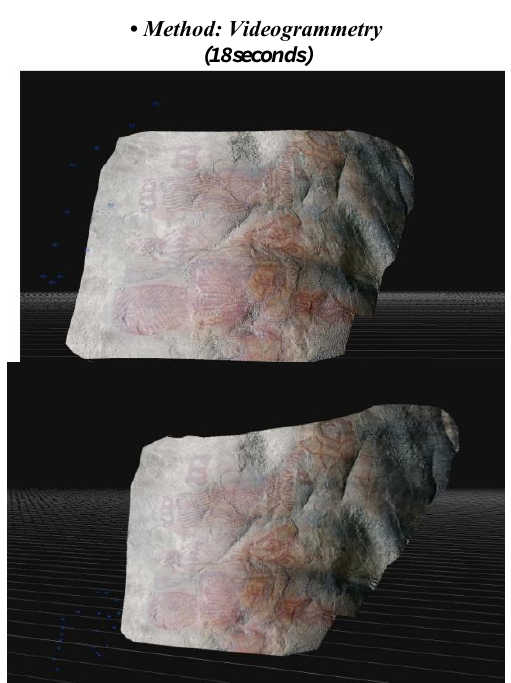
Figure 9. Pictograph reconstruction, texture mesh. Disordered Sequence Videogrammetric Method. Due to the magnitude of the rock and the fact that it could not Figure 8. Petroglyph reconstruction, texture mesh. Disordered be accessed directly, it was decided to capture the video from sequence videogrammetric method. different angles and heights as much as possible. The distribution of blue dots displayed in the images in figure 9 show the position of the cameras at the time of extraction of each frame. The result, in fact, is very favorable, since it meets the objective of specifically reconstructing this element, and displaying the pictograms correctly and with adequate resolution for their interpretation.